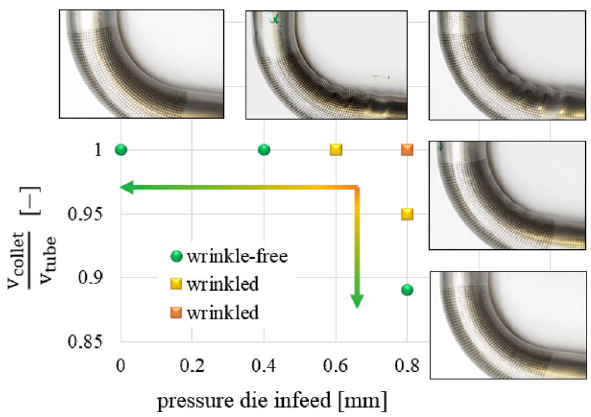
Fig. 4 Influence of the variation of the pressure die infeed and the collet speed on the formation of